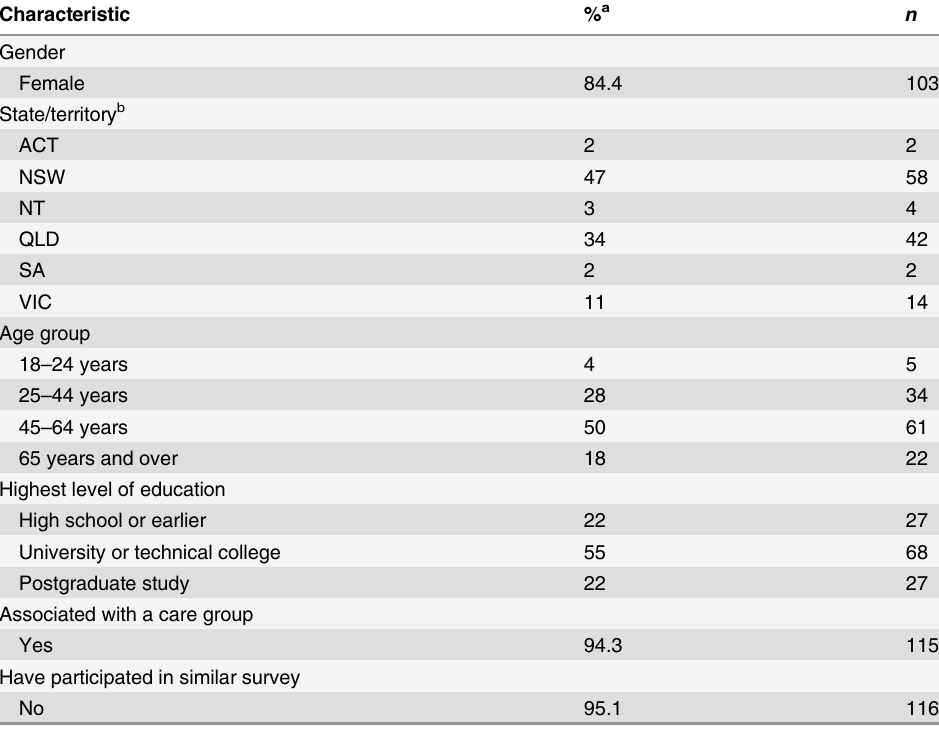
Table 1. Demographic characteristics of 122 Australian flying fox rehabilitators,